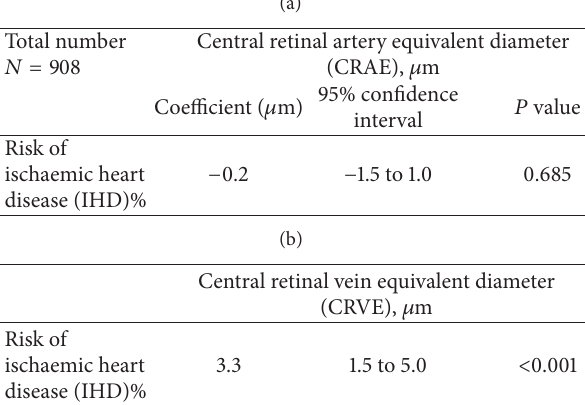
Table 2: Association between retinal vessel diameters and the risk of ischemic heart disease (IHD) after adjustment for